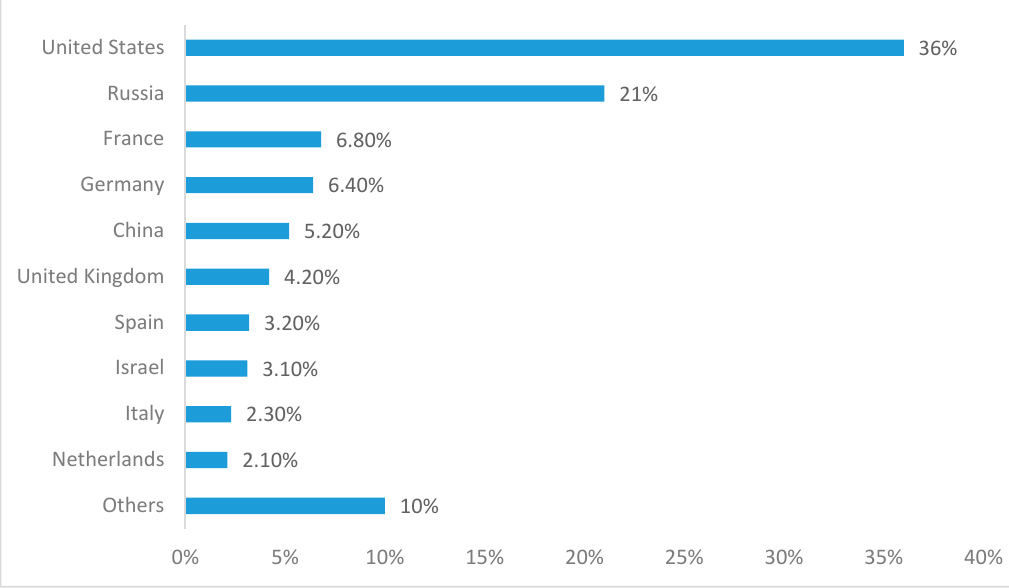
Figure 1. Global share of major arms exports by the 10 largest exporters, 2014–2018.